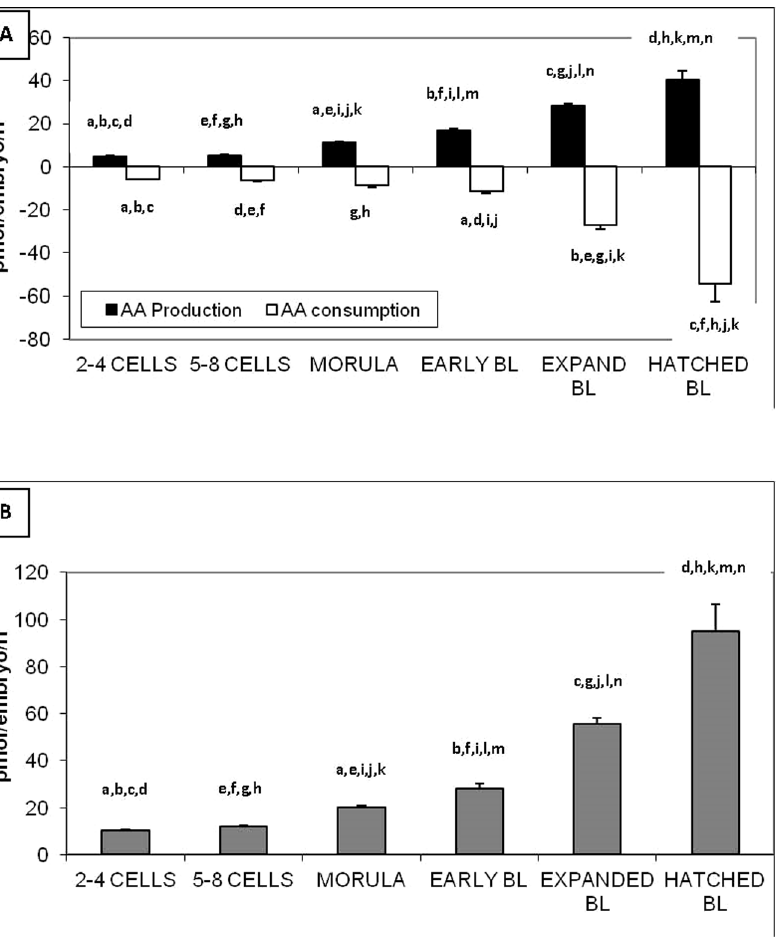
Figure 1. Amino acid production/consumption (A) and turnover (B) throughout preimplantation development by individual bovine embryos produced invitro . Turnover is the sum of amino acid consumption and production. Values with the same superscript are significantly different (p , 0.05). doi:10.1371/journal.pone.0067834.g001 PLOS ONE |